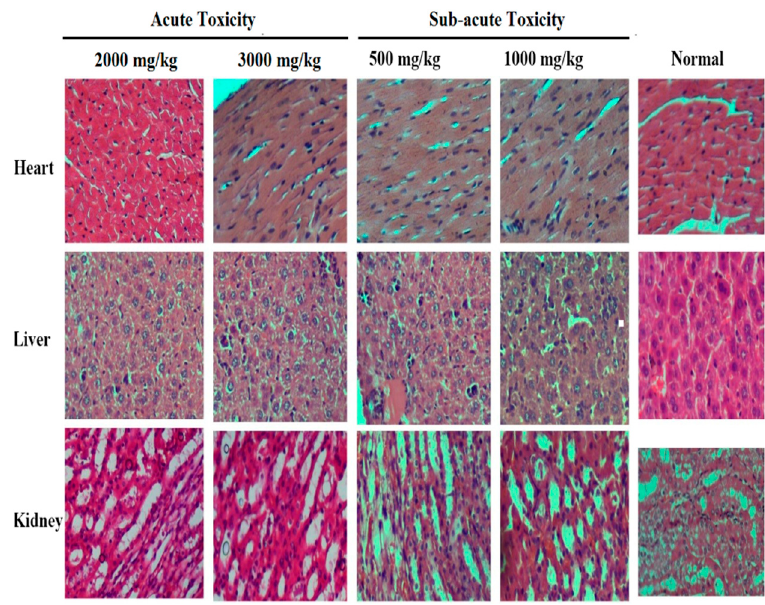
Figure 5. Histopathological investigation.